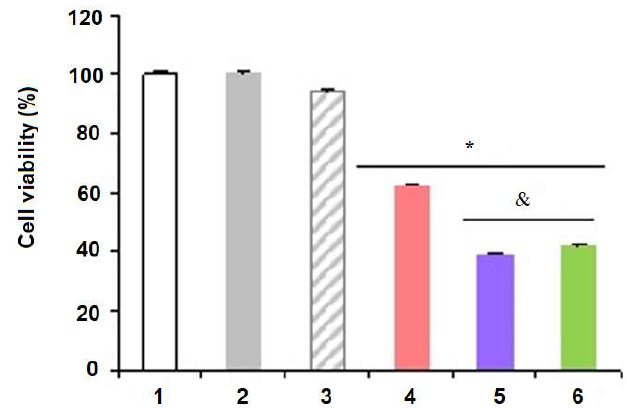
1 Figure 6. MCF-7 cells viability obtained by cell counting method, where ( 1 ) Control 1 (DMEM); ( 2 ) LNC + ; ( 3 ) Phe-Zn-MLNC; ( 4 ) Phe-Zn-MLNC-MTX(OEt) 2 ; ( 5 ) MTX(OEt) 2 -Zn-MLNC; Figure 6. MCF-7 cells viability obtained by cell counting method, where (1) Control 1 (DMEM); (2) LNC + ; (3) Phe-Zn-MLNC; (4) Phe-Zn-MLNC-MTX(OEt) 2 ; (5) MTX(OEt) 2 -Zn- ( 6 ) MTX-Zn-MLNC-MTX. Data represent mean ± SD ( n = 3), * p < 0.05 vs. Control (ANOVA, Tukey); MLNC; (6) MTX-Zn-MLNC-MTX. Data represent mean ± SD ( n = 3), * p < 0.05 vs. Control & p < 0.05 vs. Phe-Zn-MLNC-MTX(OET) 2 (ANOVA, (ANOVA, Tukey); & p < 0.05 vs. Phe-Zn-MLNC-MTX(OET) 2 (ANOVA, Tukey).